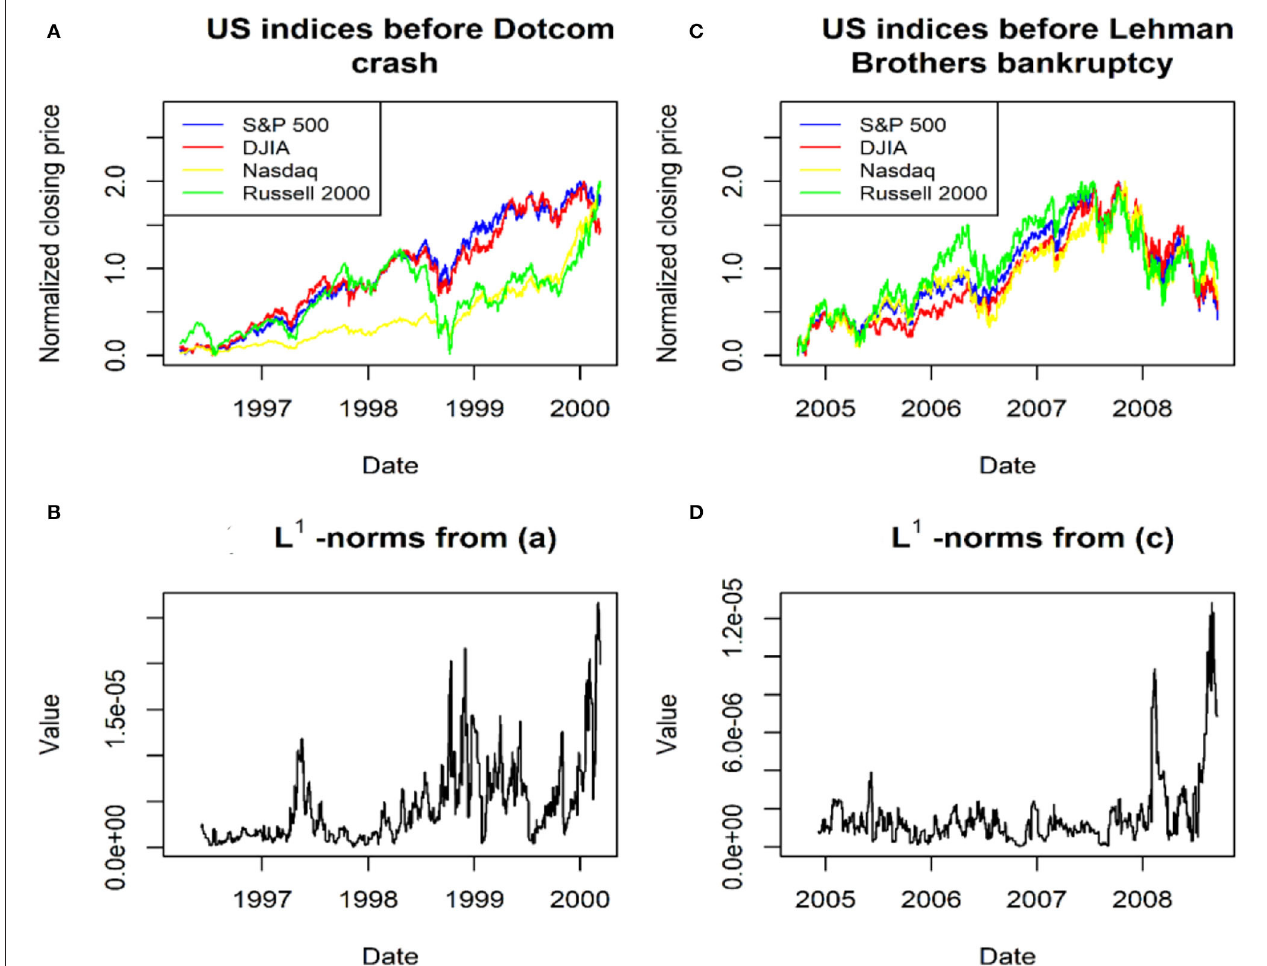
FIGURE 5 | (A,C) two pre-crisis datasets before the Dotcom crash and Lehman Brothers bankruptcy and (B,D) the two L 1 -norm time series for these two datasets, respectively.